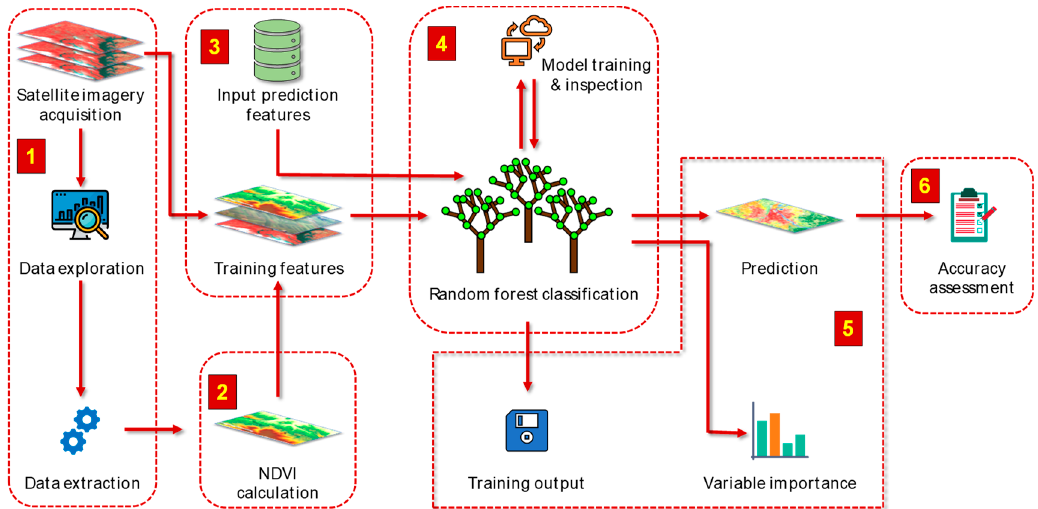
Figure 1. Workflow of the automated data processing and analysis steps employed to perform forest-based classification. This methodology was divided into six main steps for a better understanding of this tool’s workability and to facilitate future studies. Note: normalized difference vegetation index— NDVI.